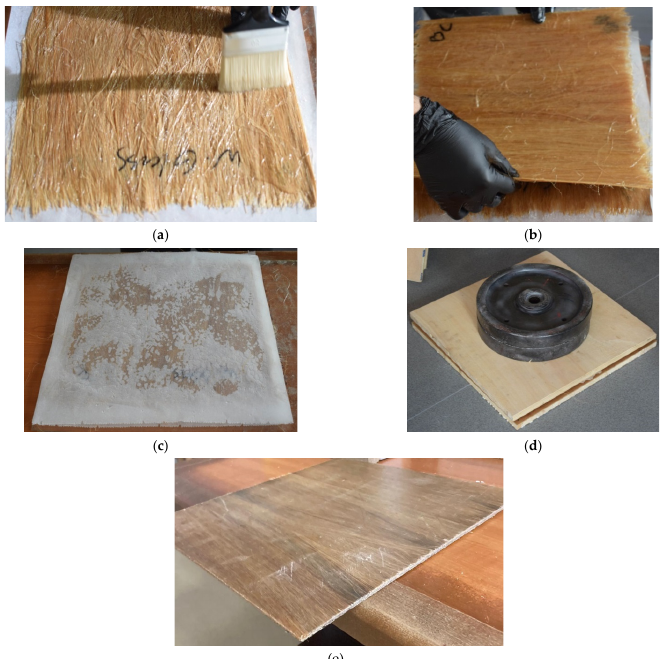
Figure 3. Composite manufacturing: ( a ) impregnation of the first layer with BK epoxy resin; ( b ) arrangement of middle date-palm layer; ( c ) composite covered by white silicone baking paper; ( d ) composite placed between two block board panels and pressed by two calibrated weights of 10 kg; ( e ) final composite panel.